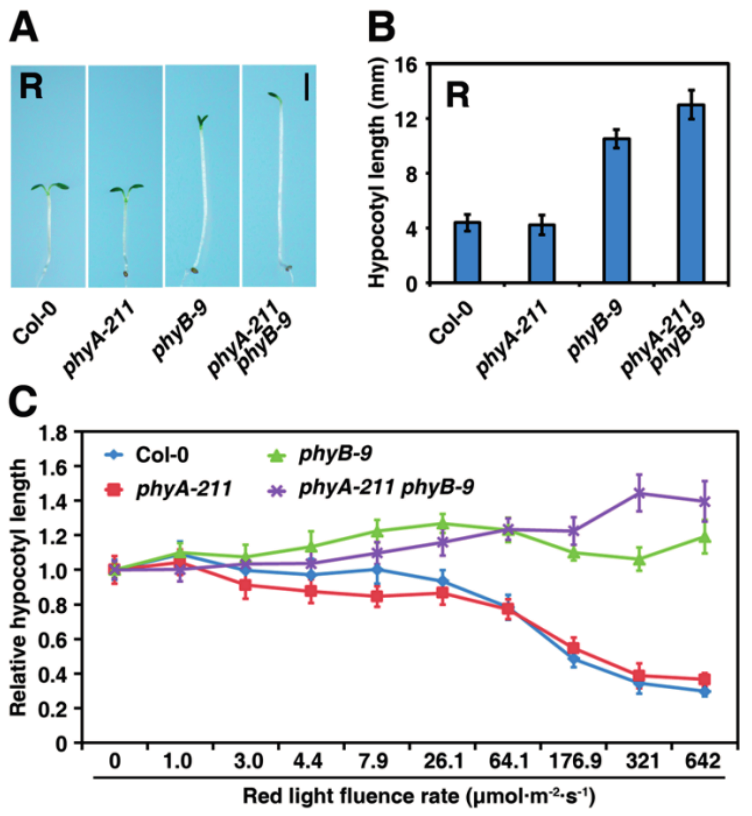
Figure 1. PhyA and phyB function coordinately to inhibit hypocotyl elongation under red (R) light. ( A ) Representative seedlings of the WT Col-0, phyA-211 , phyB-9 and phyA-211 phyB-9 mutants grown under R light (321 μ mol·m − 2 ·s − 1 ) for 4 days. Bar = 2 mm; ( B ) Quantification of hypocotyl lengths of seedlings shown in A. The means of